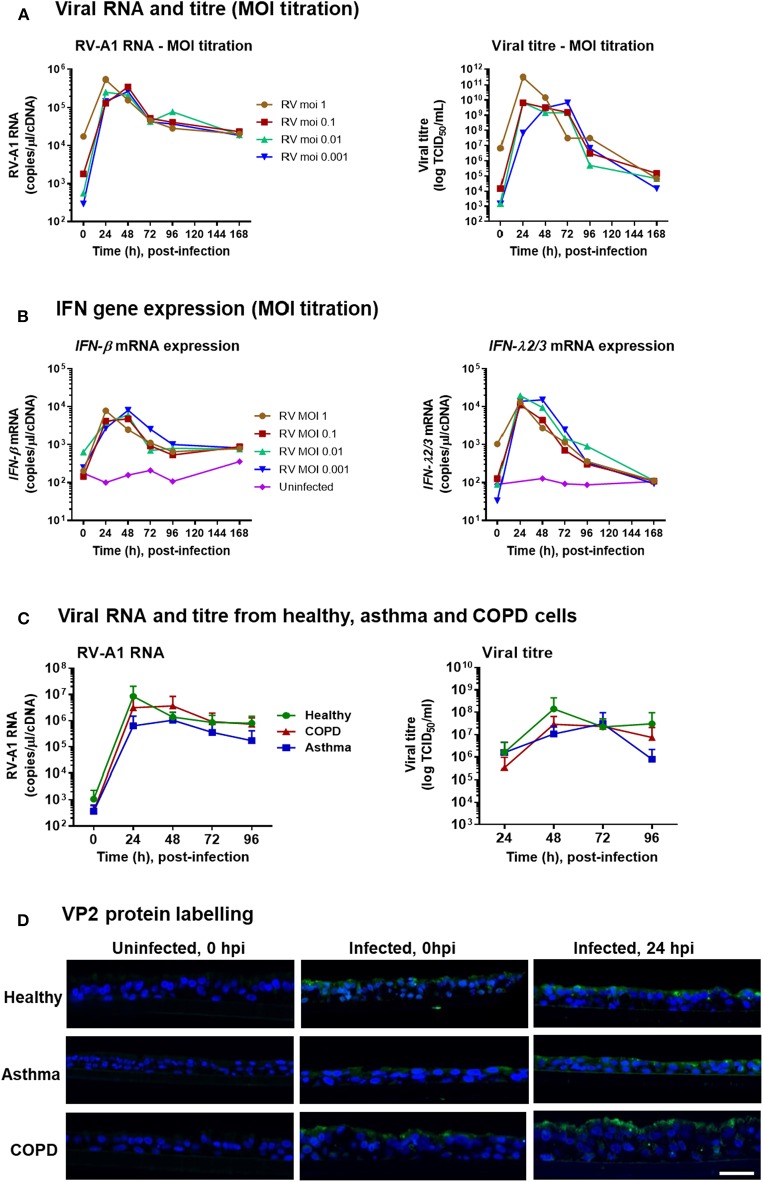
RV-A1 dose titration in differentiated BECs obtained from healthy donor and low MOI infection of differentiated BECs obtained from healthy donors, and donors with asthma or COPD. ALI cultures were infected with RV-A1 at the indicated doses, ranging from 0.001 to 1. Time course analysis was performed for viral RNA by RT-PCR and extracellular infectious virus release by TCID50 assay (A), IFN-β gene expression and IFN-λ gene expression by RT-PCR (B). Subsequent cultures were infected with RV-A1 at a MOI of 0.001 (n = 5 per group). Time course analysis for virus quantification based on RNA assessed by qPCR and extracellular virus by TCID50 assay (C). Data represented as mean ± SD. Representative immunofluorescence images of RV VP2 protein staining in paraffin-embedded sections (D). Scale bar: 25 μm.